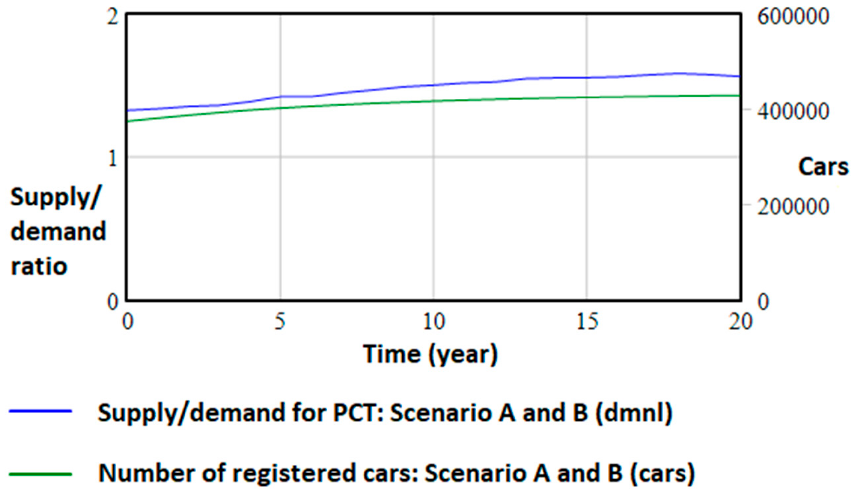
Figure 9. Trend in registered cars and supply and demand rates in PCT (dimensionless-Dmnl).